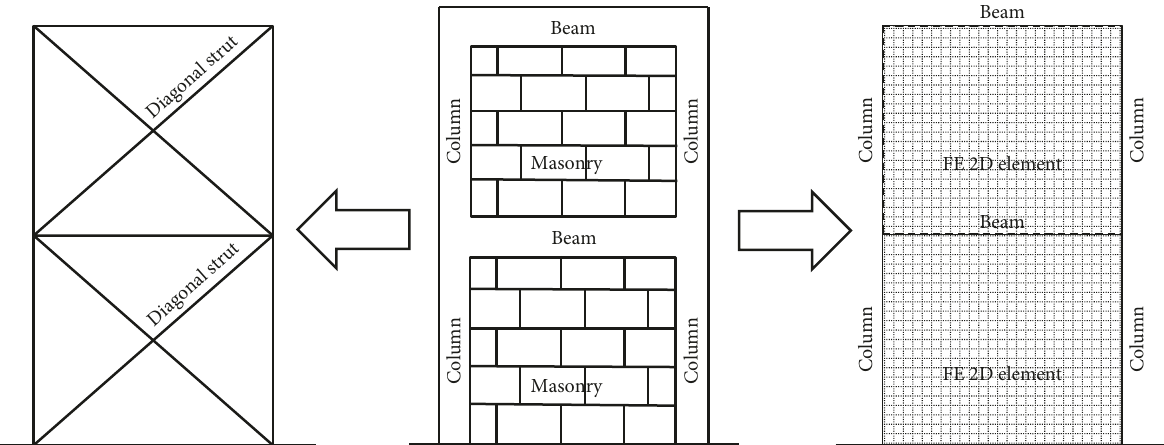
Figure 3: Macrofinite element approach and microfinite element approach.